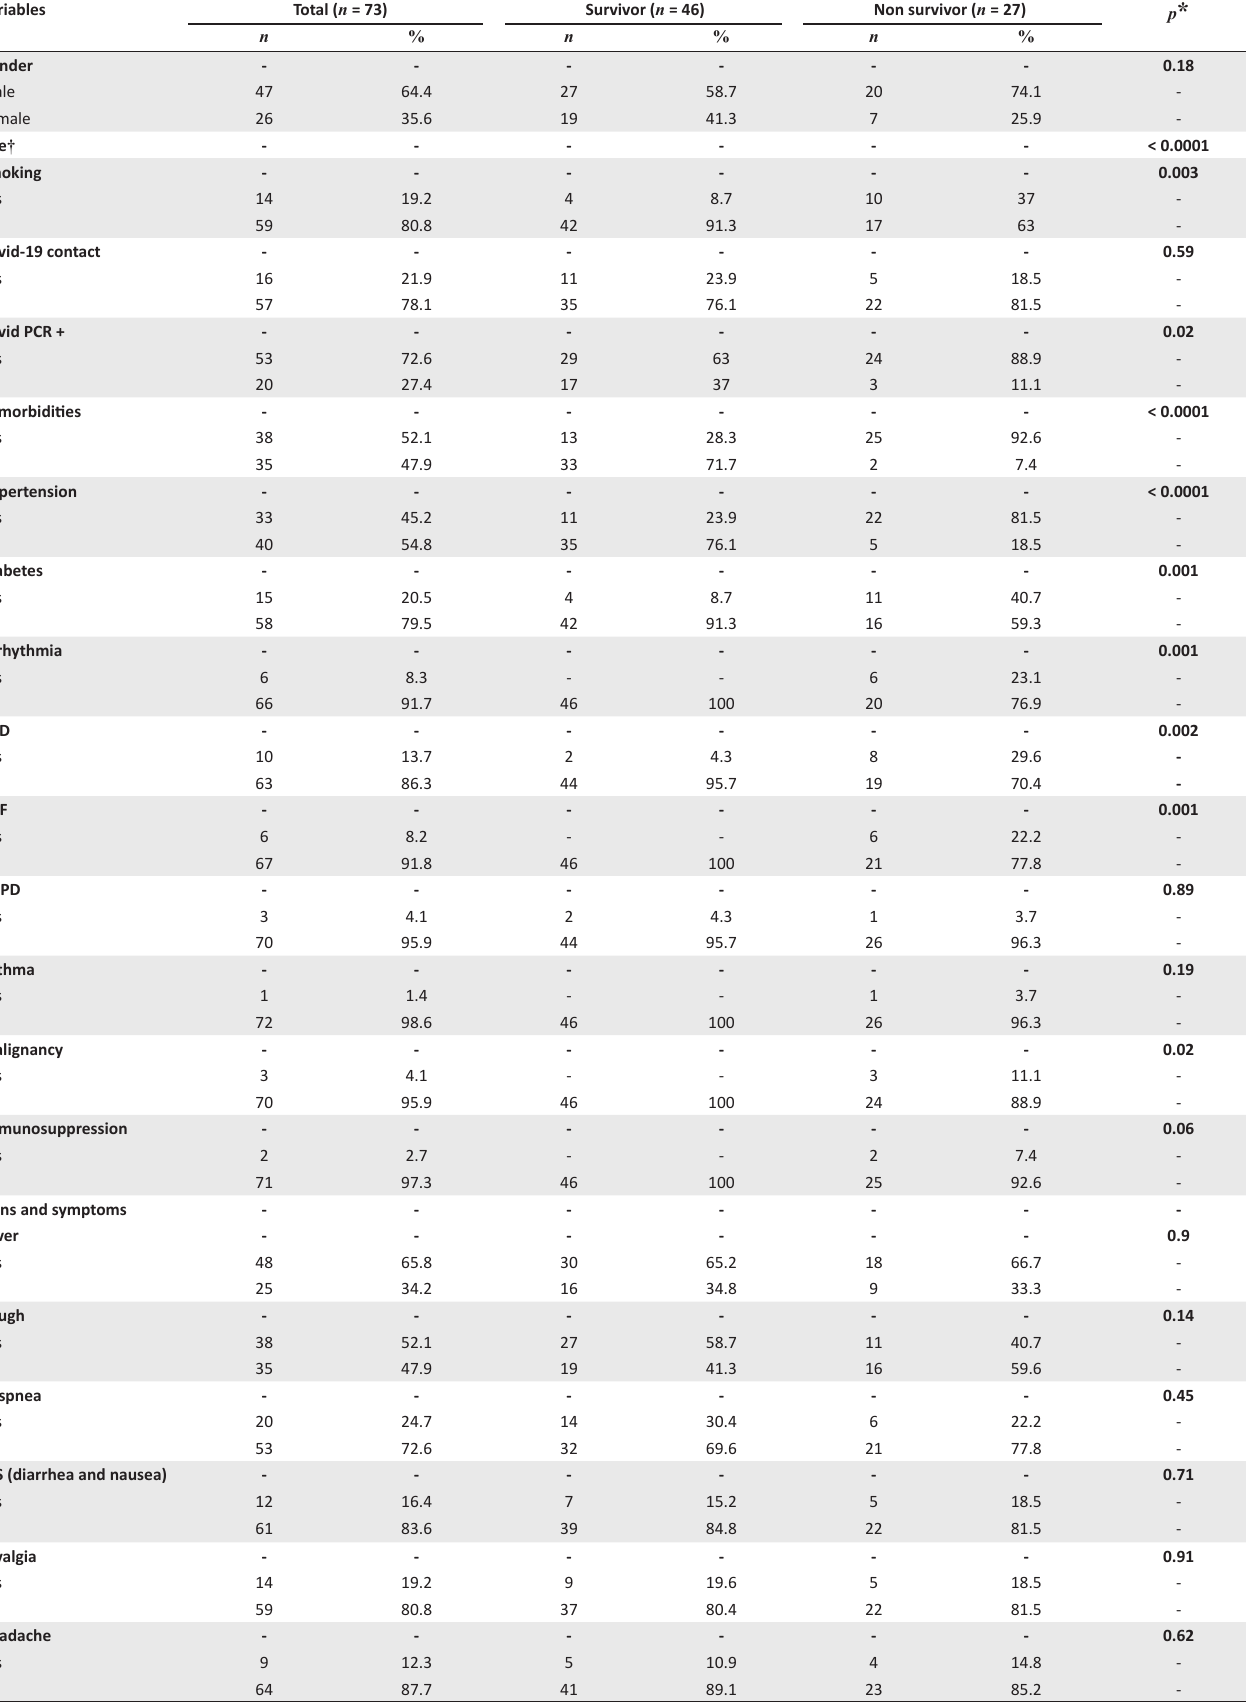
TABLE 1 : Demographics, baseline and clinical characteristics at presentation of patients treated with lopinavir/ritonavir.